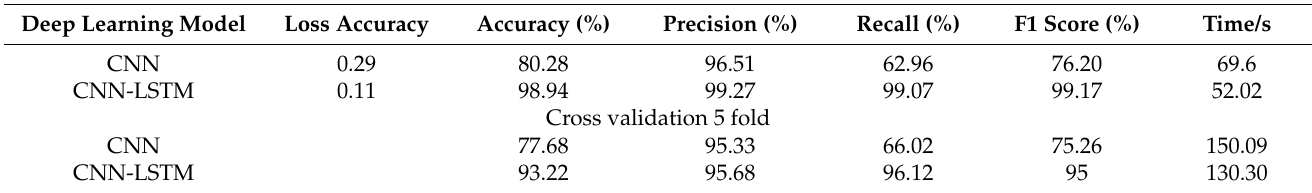
Table 7. Empirical results of the CNN and CNN-LSTM deep learning